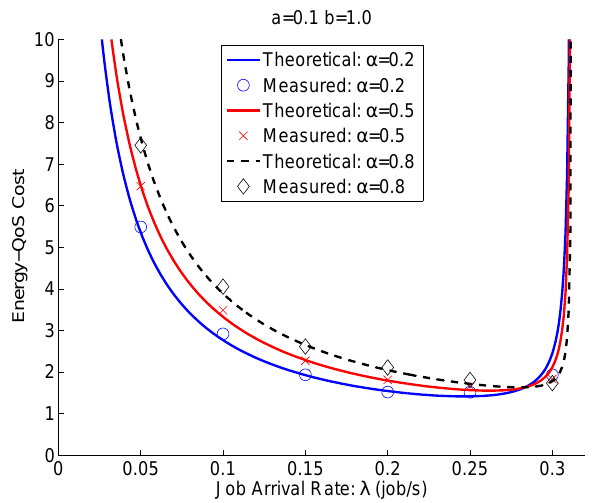
Figure 6. Energy–QoS cost vs . job arrival rate λ .